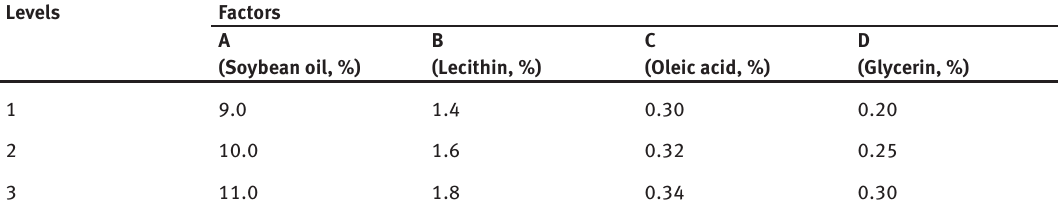
Table 1: Orthogonal experimental